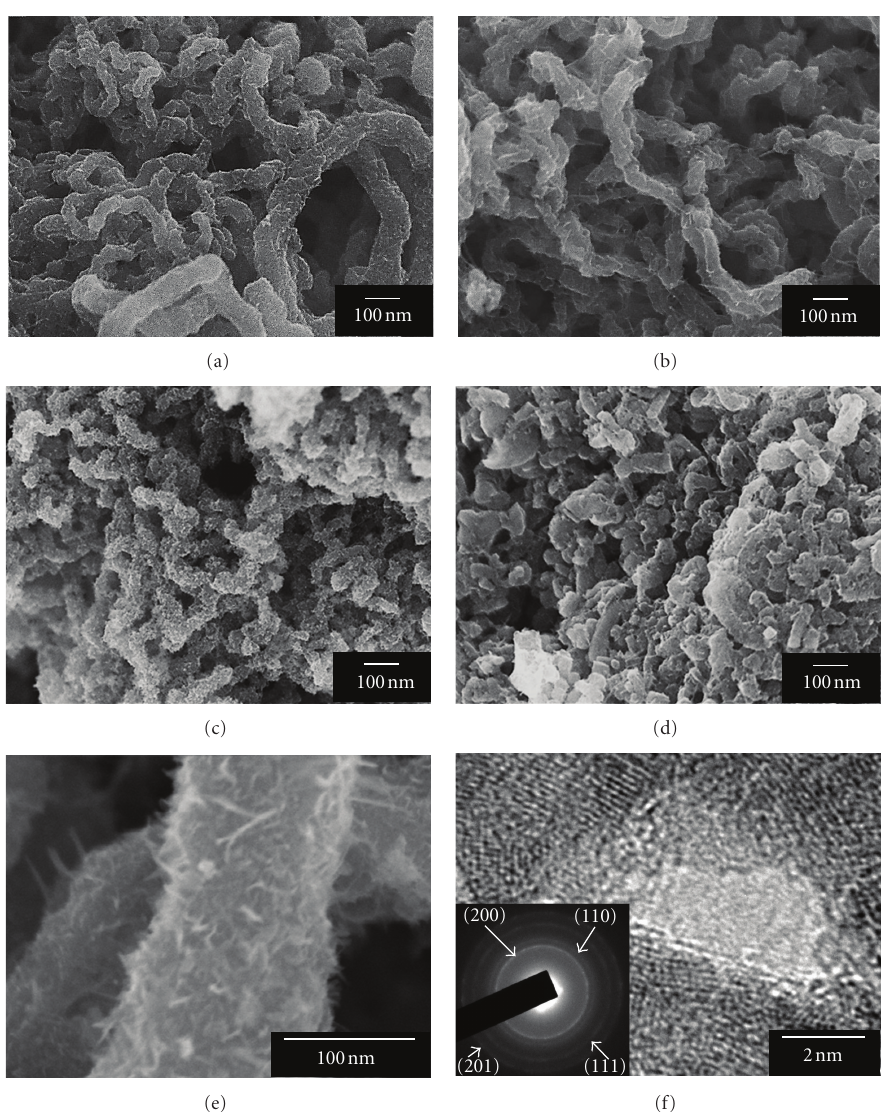
Figure 3: FESEM micrographs of MnO 2 /CNxNTs/CC hybrid electrodes, fabricated via spontaneous reduction, for di ff erent deposition time (a)–(d) low magnification, (e) high magnification. (f) HRTEM images and the corresponding selected area electron di ff raction pattern of MnO 2